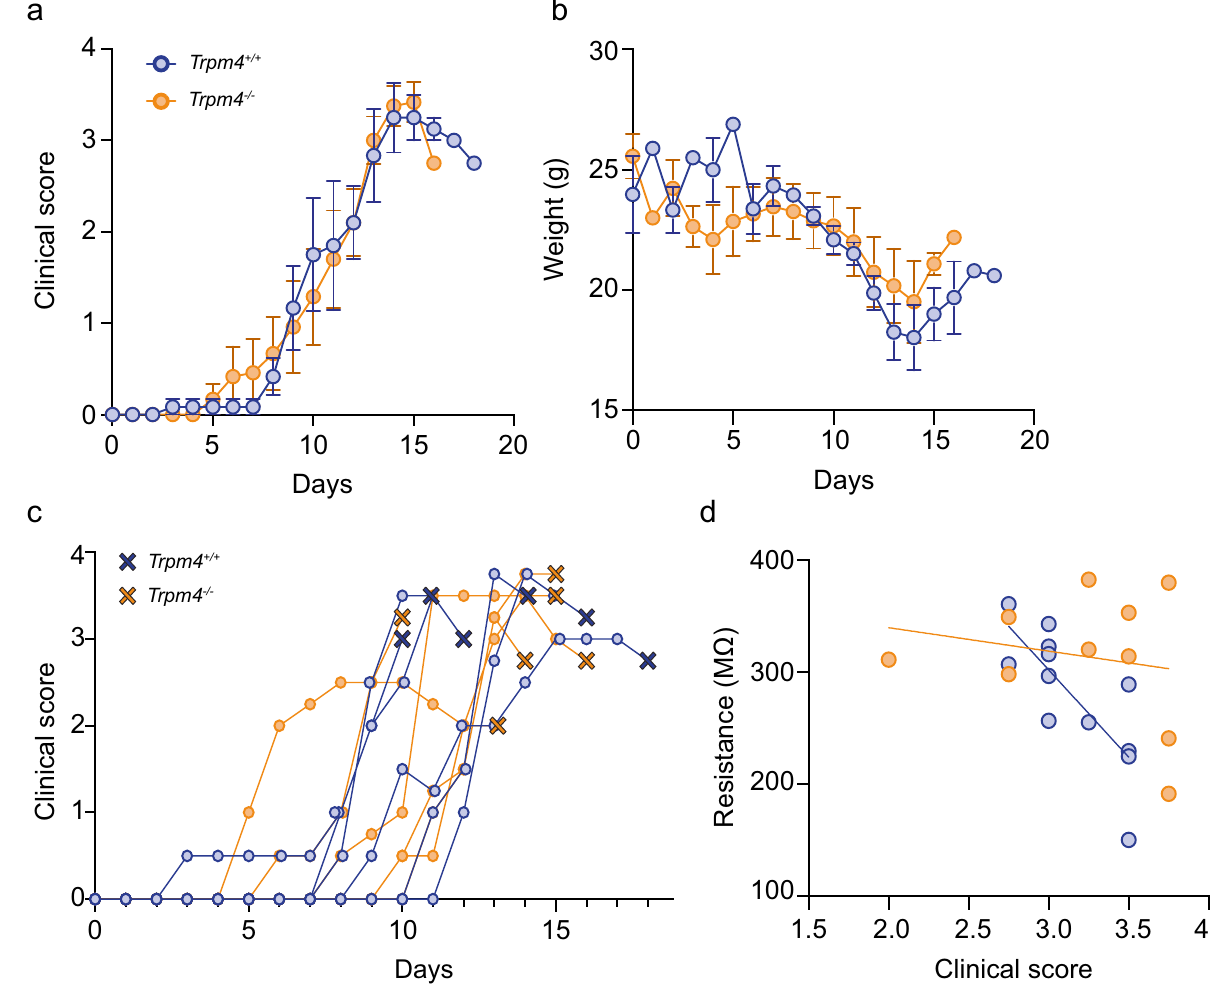
Figure 3. The induction and acute phase of EAE was not different in Trpm4 –/– and Trpm4 + / + littermates. ( a ) Daily clinical scores and ( b ) body weight of Trpm4 –/– (orange circles, n = 6 mice) and Trpm4 + / + (blue circles, n = 6 mice) littermates recorded daily after induction of experimental autoimmune encephalomyelitis (EAE) on day 0 (mean ± SEM). ( c ) EAE clinical progression of individual mice and score at time of sacrifice for electrophysiology (X’s). ( d ) Cell resistance was calculated from 200 ms–10 pA current injections in drug-free ACSF. Cell resistance is negatively correlated with the final clinical score in Trpm4 + / + mice (Pearson’s r = − 0.77, p = 0.0035) but not in Trpm4 –/– mice (Pearson’s r = − 0.2, p =